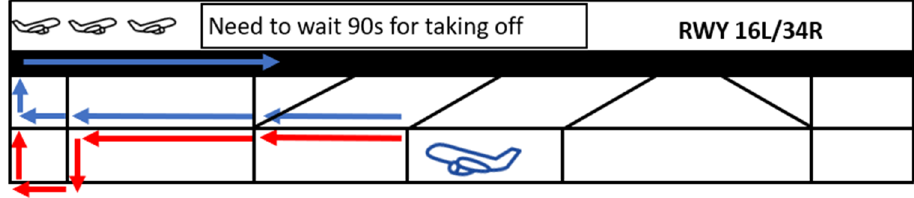
Figure 16. “Pretend to ignore congestion” in MILP with RH.